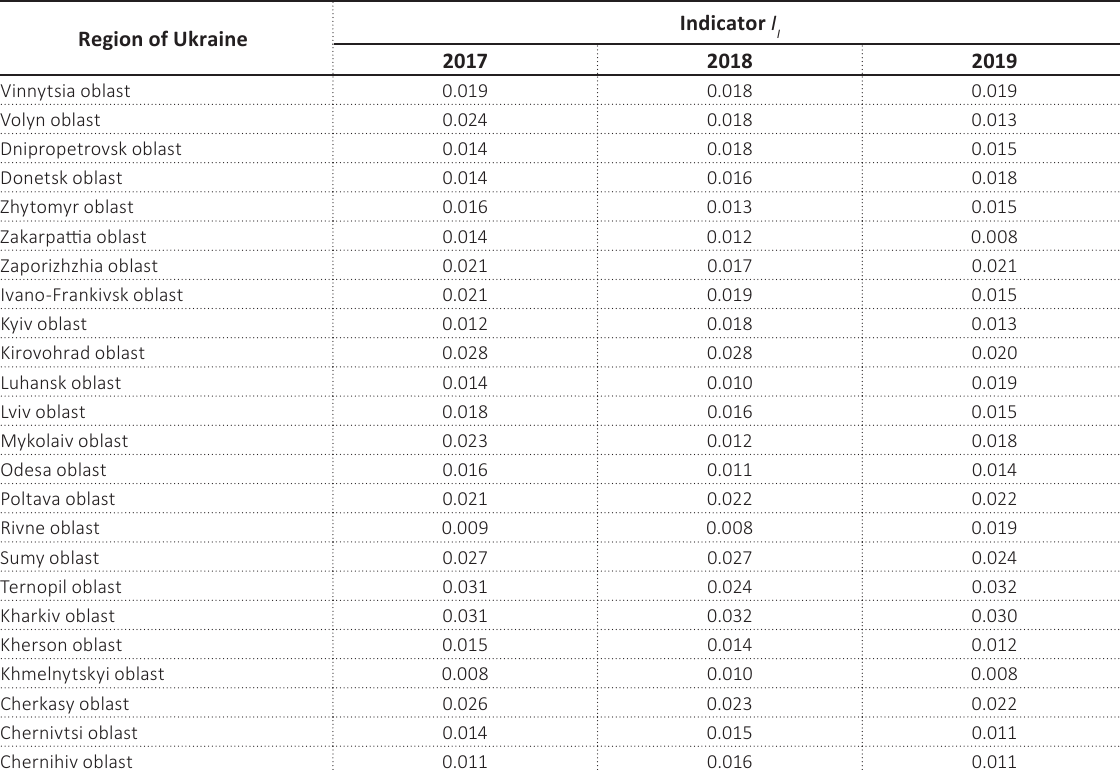
by regions of Ukraine, I